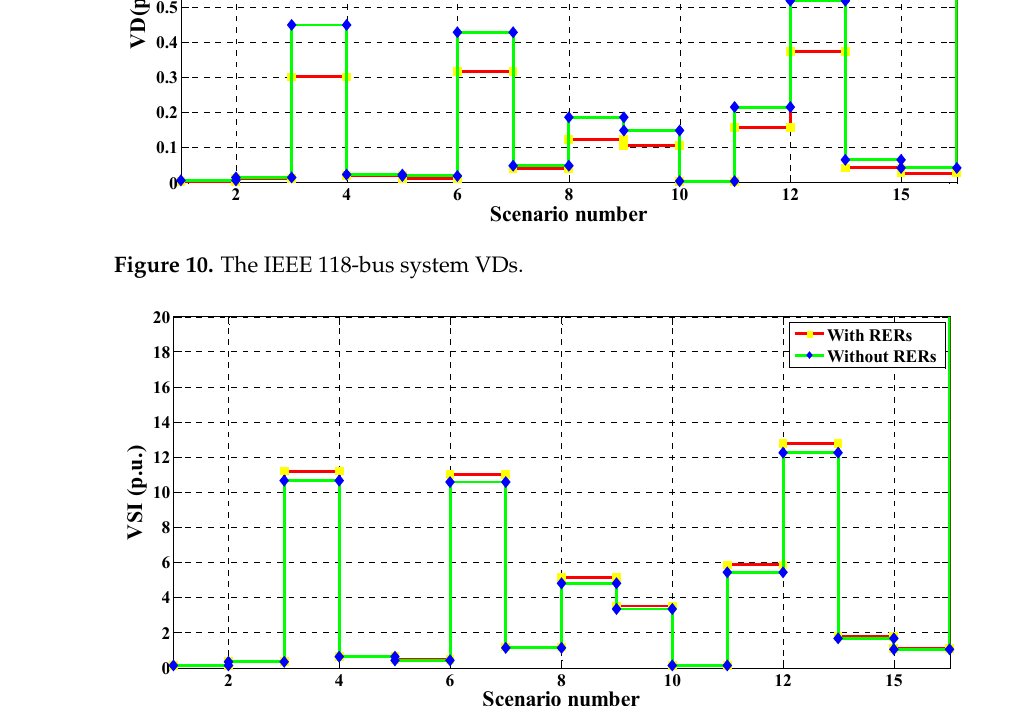
Figure 11. The IEEE 118-bus system VSIs.